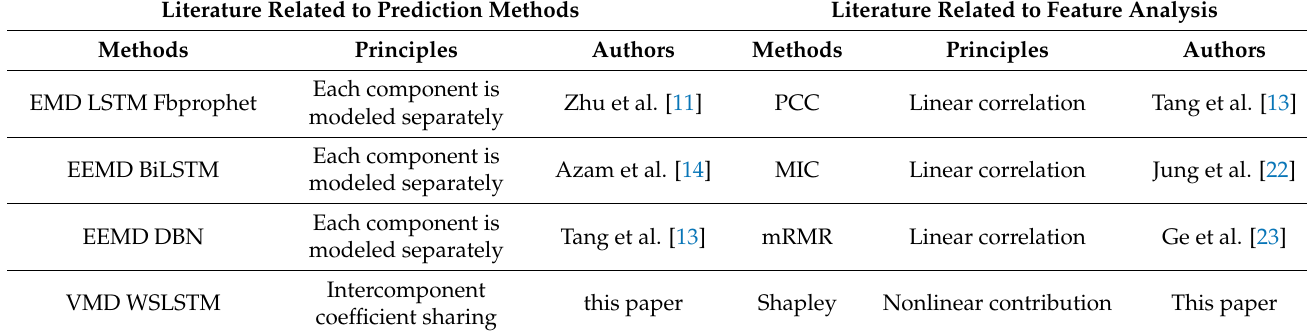
Table 1. Comparison between the proposed method and traditional